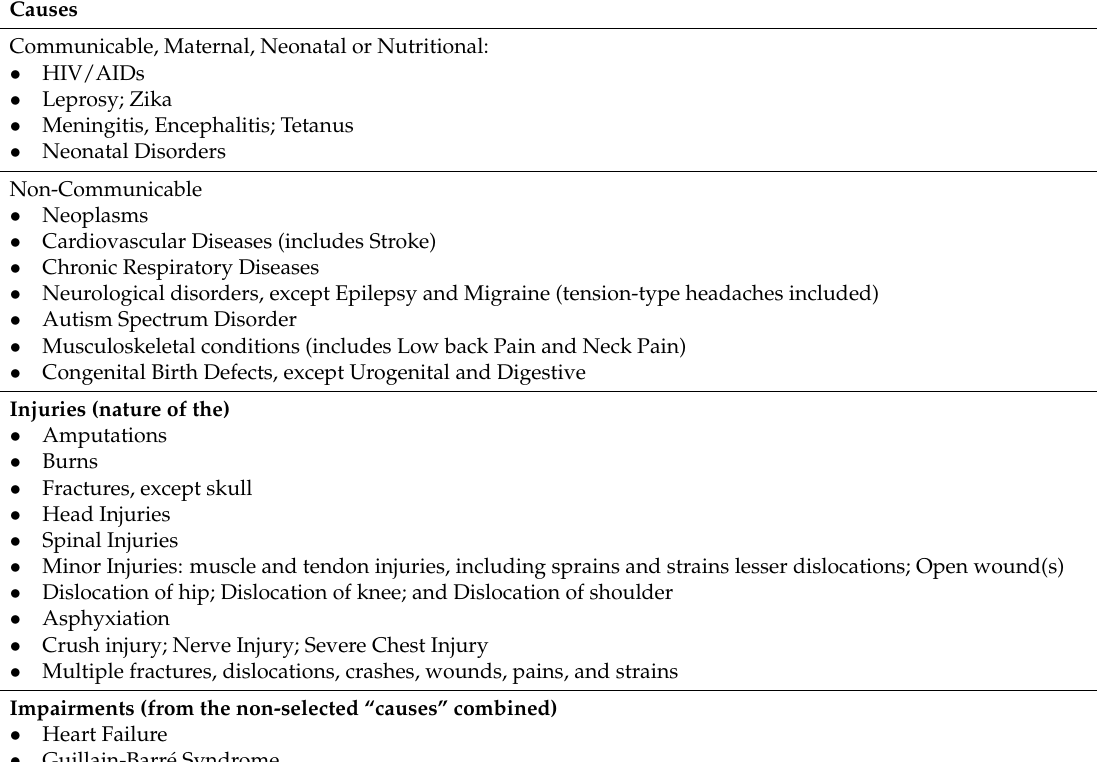
Table 1. List of GBD causes, injuries and impairments selected as generating YLDs that might potentially benefit from physical